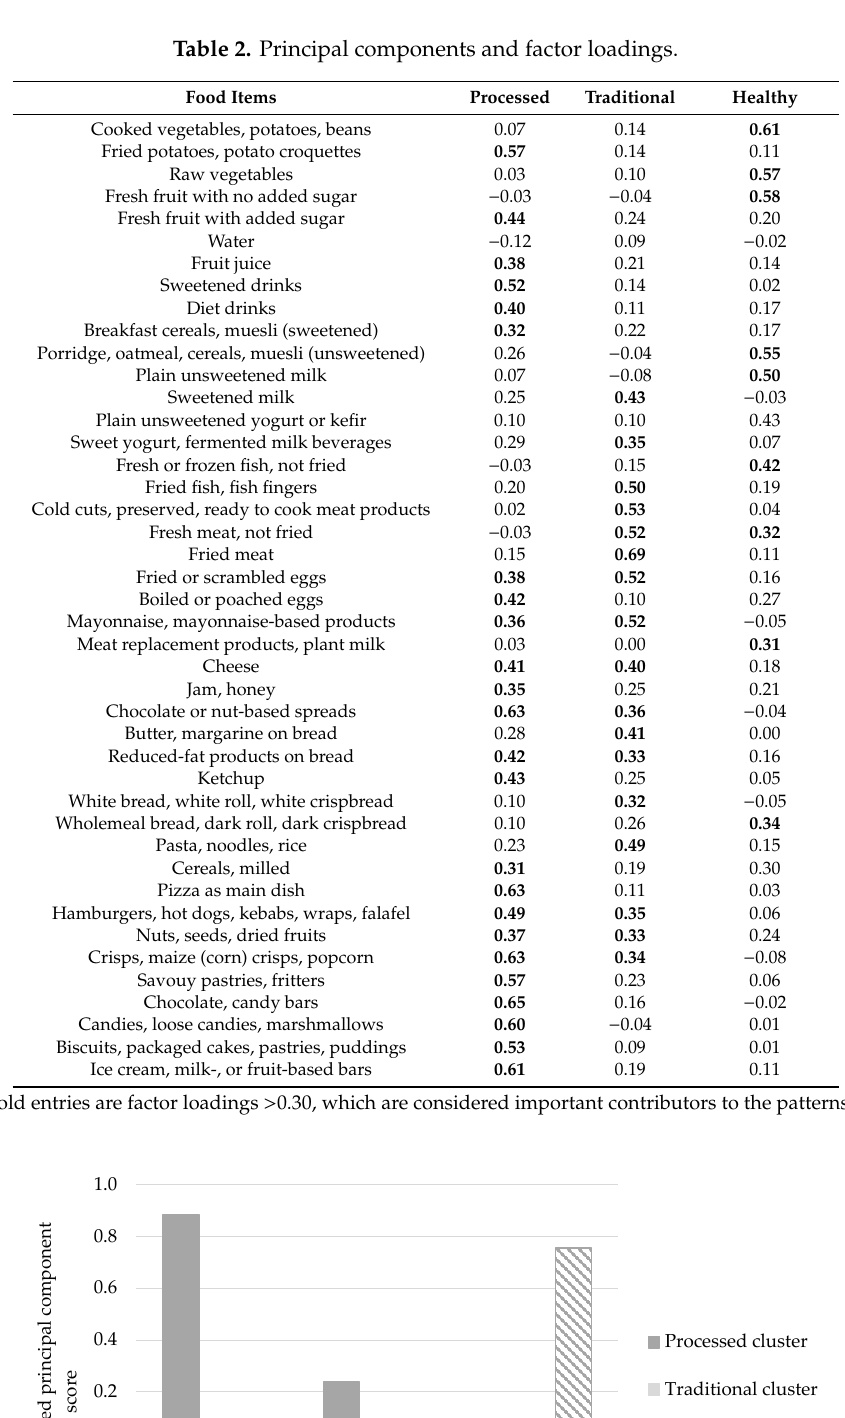
Table 3. Adolescent and family characteristics in the total population and stratified by dietary pattern cluster.